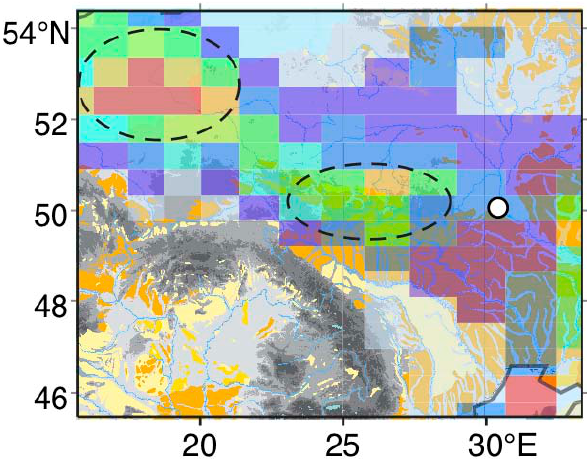
Fig. 5. Annual mean of dust emission fluxes for GS (Fig. 4a) super- imposed on the topographic